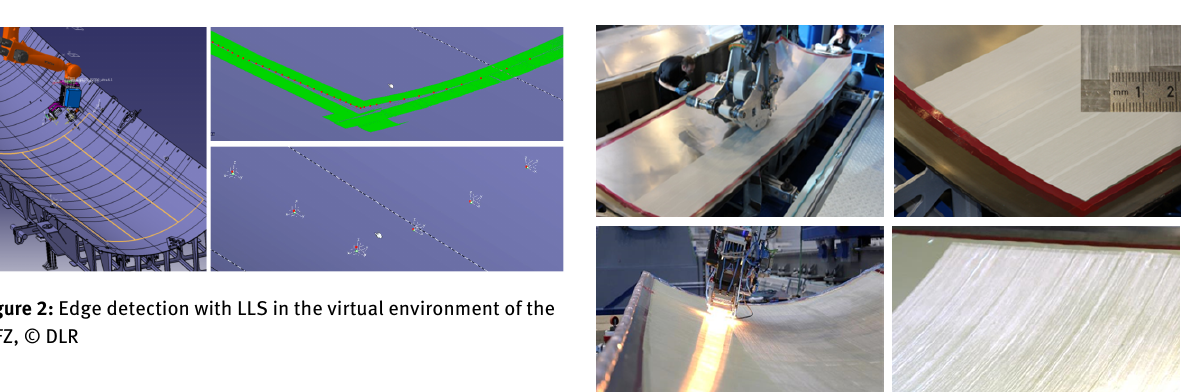
point cloud with a resolution of 0.15 mm point to point dis- tance on one scan line and 0.5 mm distance between indi- vidual lines (see Figure 2 top right). The LLS is monitored with a laser tracker. This system can determine the posi- tion of the end-effector with an accuracy of approximately ± 60 µm and thus exclude the tolerance of the robot move- ment from the error chain.